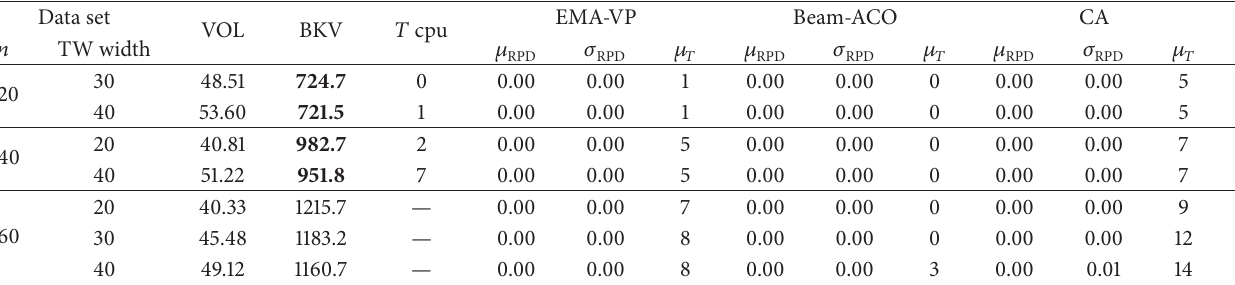
Table 5: Computational results on benchmark set